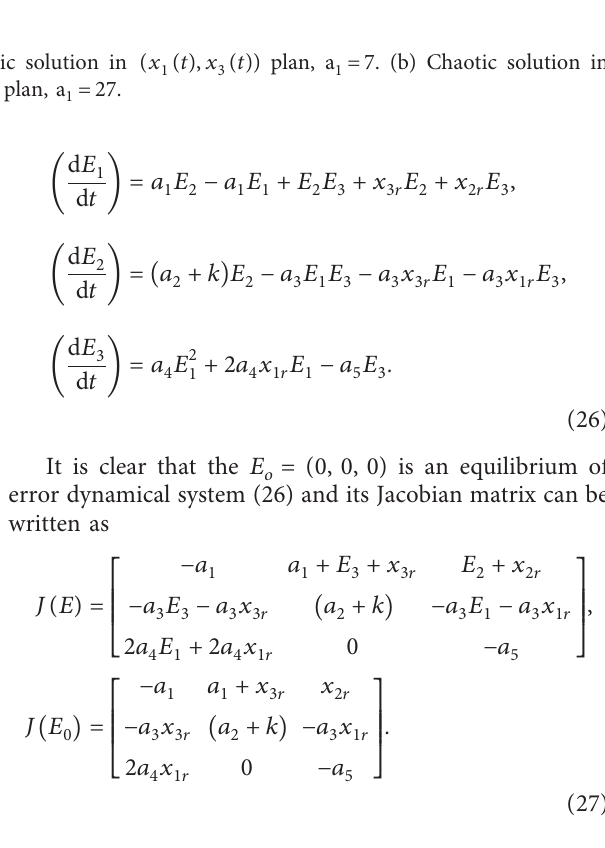
� 7. (b) Chaotic solution in 1